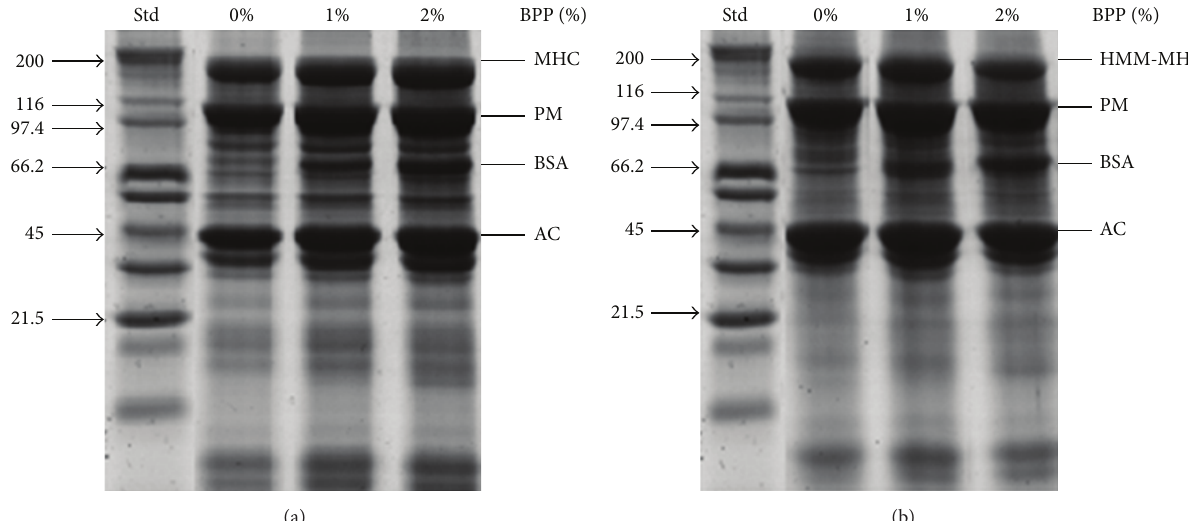
Figure 5: Electrophoretic profile of proteins of sols (a) and gels (b) from giant squid ( Dosidicus gigas ) added with different concentrations of BPP (0, 1, and 2%). Line 1: marker of broad range (Std); line 2: sol control; line 3: sol with 1% BPP; line 4: sol with 2% BPP. MHC, myosin heavy chain; PM, paramyosin; BSA, bovine serum albumin; AC, actin. ( Saurida tumbil ), obtaining values of 198.56 and 225.32 g for